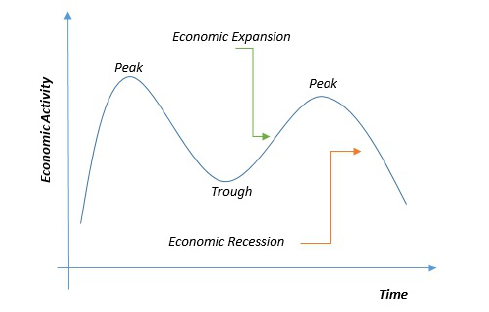
Figure 3. The business cycle can be classified into four stages: (1) expansion when economic activity grows steadily; (2) boom when the aggregate demand grows more than the aggregate output which overheats the economy; (3) recession phase when the aggregate output cool down after a peak; (4) recovery after a through. The so-called “specific cycle amplitude” corresponds to the vertical distance between the peak and the